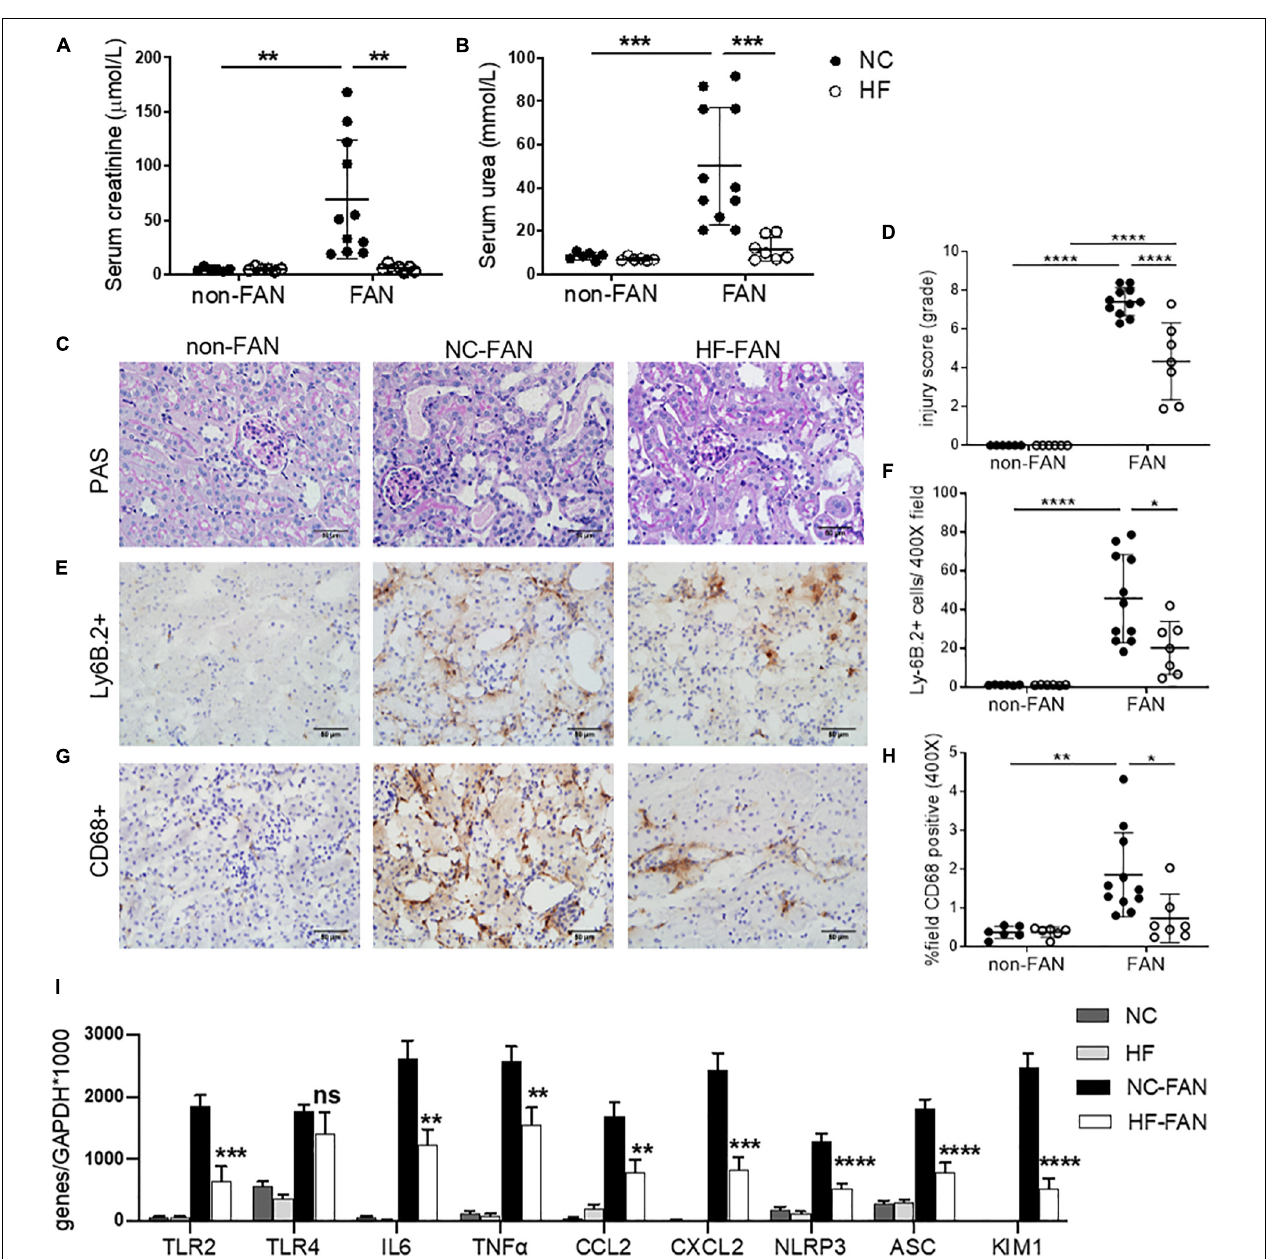
FIGURE 1 | High fiber (HF) diet ameliorates acute kidney injury (AKI) and inflammation in folic acid nephropathy (FAN) at day 2. Folic acid (FA) injection induced AKI in normal chow (NC) fed mice, with peak serum creatinine and blood urea nitrogen (BUN) at day 2. High fiber (HF) fed mice were protected from FA induced AKI with lower serum creatinine (A) , BUN (B) and tubular injury scores (D) compared to NC. (C) Representative sections from HF and NC fed FAN and NC fed non-FAN mice at day 2 (PAS stained, × 400 magnification). Representative sections of kidney from mice at day 2 demonstrating increased Ly6B.2 + neutrophil (E) and CD68 + macrophage (G) infiltration in NC fed FAN mice compared to controls, which was attenuated by HF feeding (F,H) . (I) mRNA expression of innate immune receptors (TLR2), pro-inflammatory cytokines (IL6 and TNF α ), chemokines (CCL2 and CXCL2), inflammasome components (NLRP3 and ASC), and markers of renal proximal tubular injury (KIM1) were significantly reduced in HF fed mice compared with NC fed FAN controls, as measured by real-time PCR in kidney tissue. NC, vehicle ( n = 6); HF, vehicle ( n = 6); NC, FAN ( n = 11); HF, FAN ( n = 7). Photomicrographs at 400 × , scale bar 50 µ m. Data are shown as means ± SD or mean ± SEM; * P < 0.05, ** P < 0.01, *** P < 0.001, **** P < 0.0001.